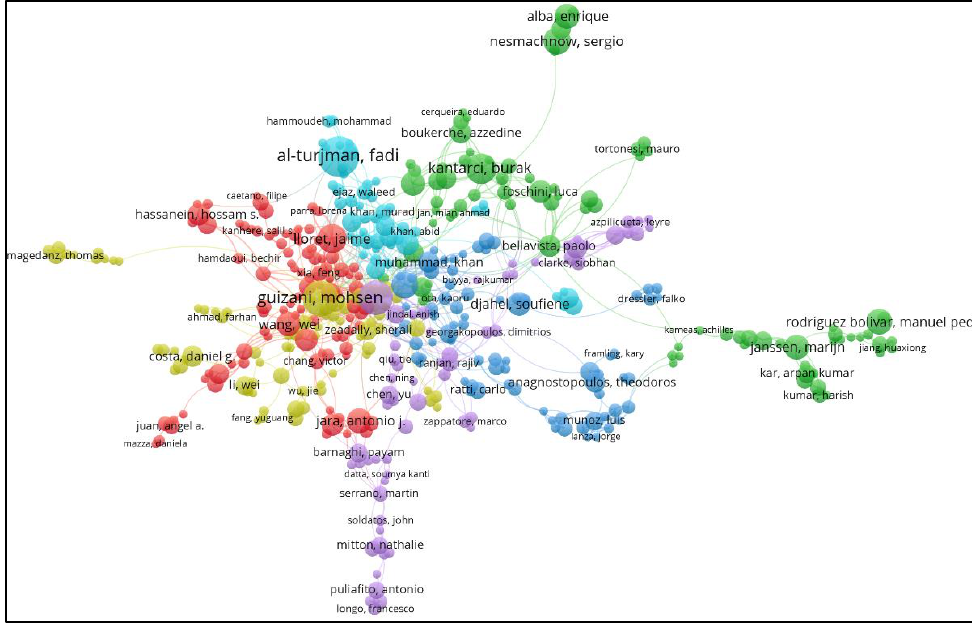
Figure 5. Bibliometric analysis of countries dealing with the topic Smart cities. Source: own analysis as per Web of Science (2022).